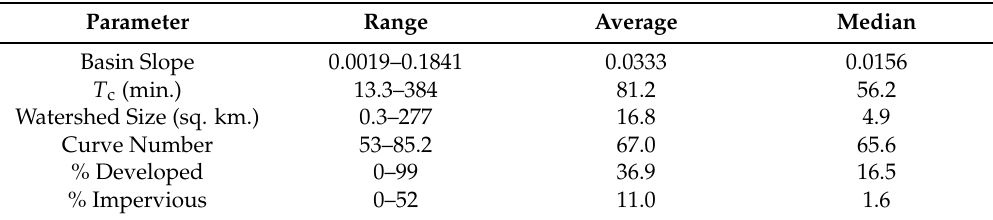
Table 4. Range, average, and median values for six watershed parameters.